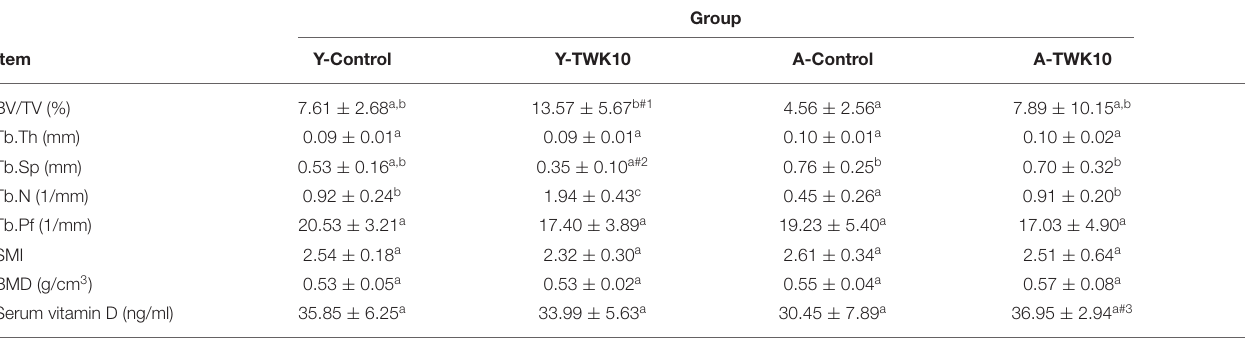
TABLE 2 | Bone quality was improved by Lactobacillus plantarum TWK10.